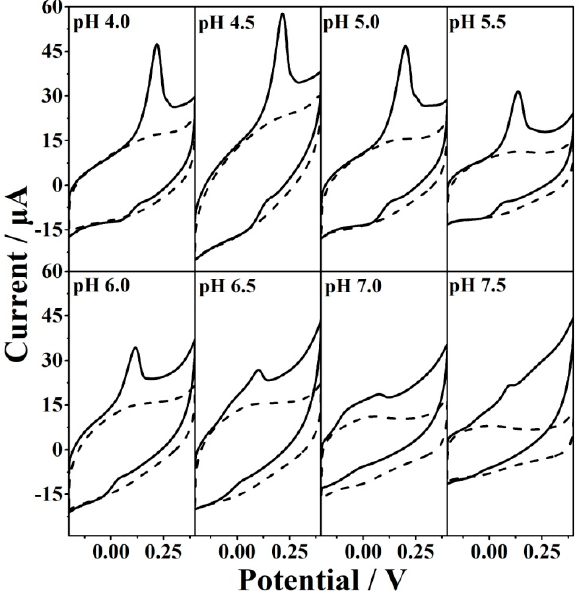
Figure 7. CVs of EGO 1/1.75V in the presence and absence of 5 mM GSH in PBS with different pHs. Figure 7. CVs of EGO 2/ − 0.85V